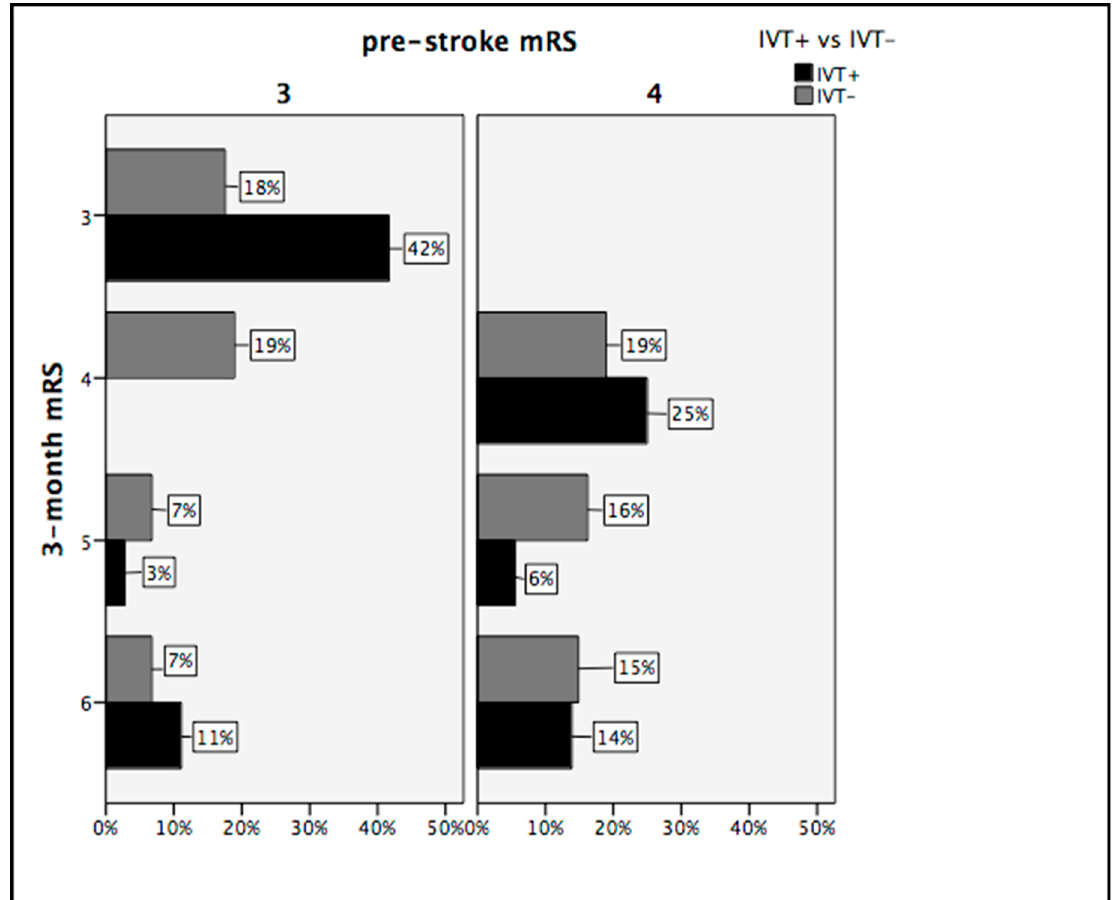
Figure 1. Functional status pre and 3 months after stroke according to intravenous thrombolysis (IVT) treatment on the modified Rankin Scale (mRS).